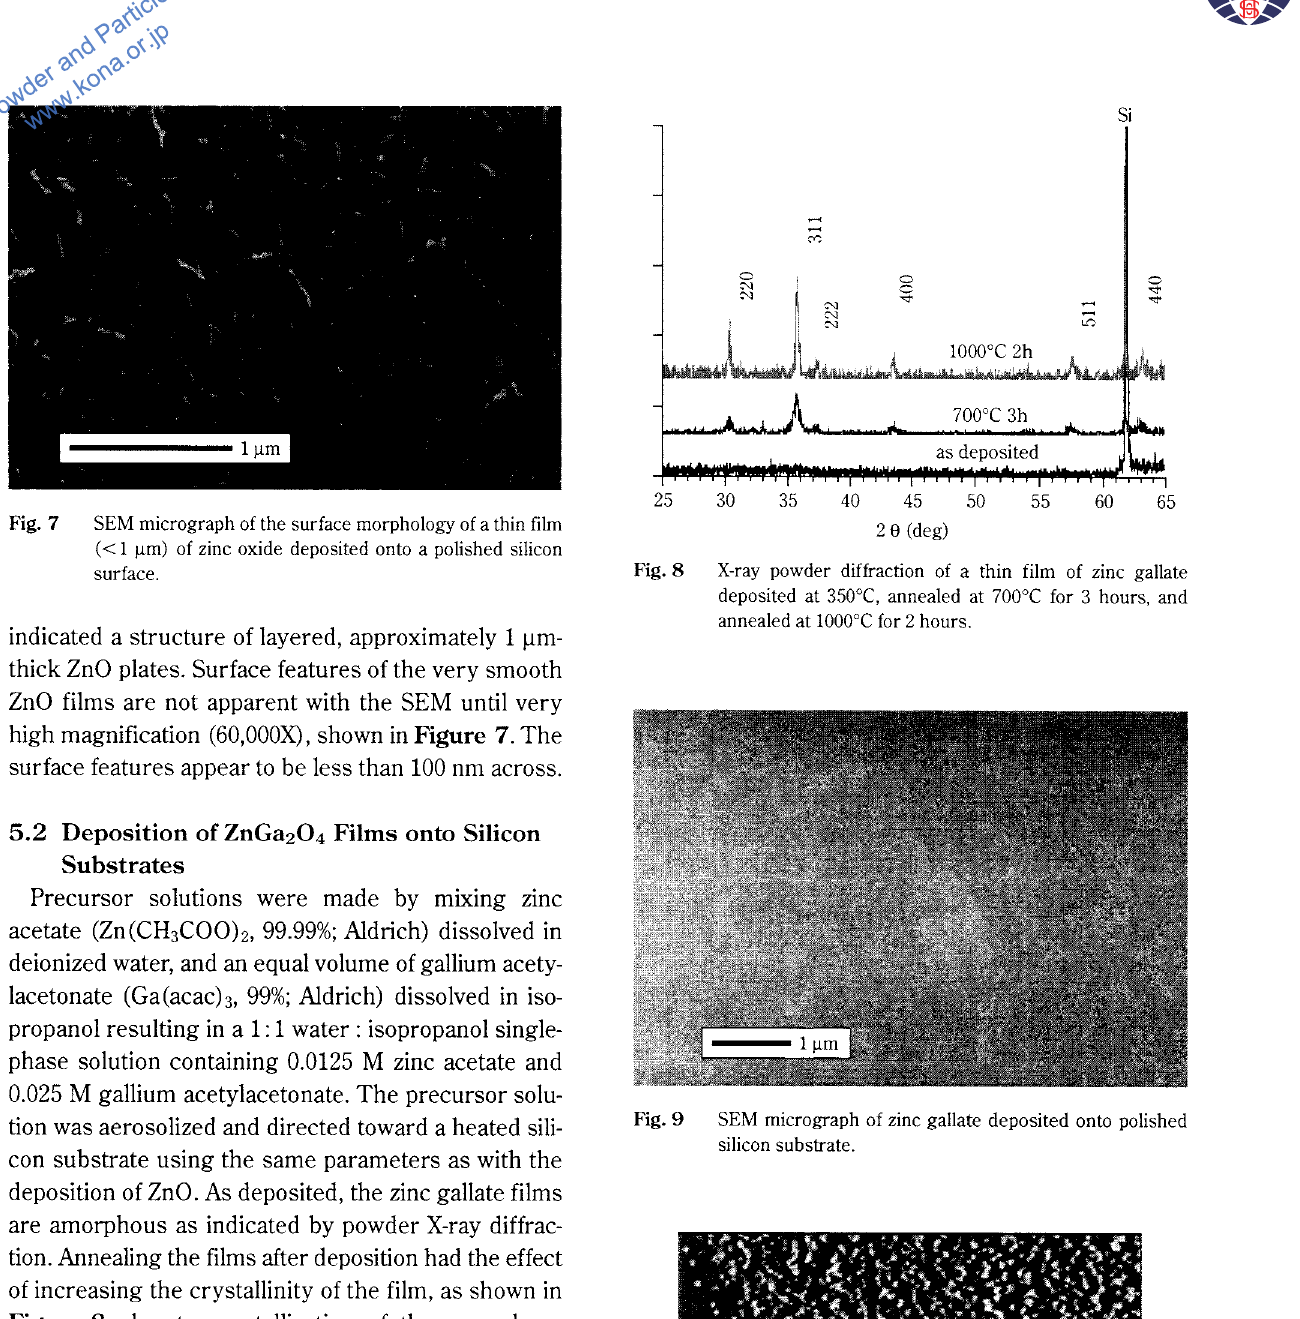
Fig. 9 SEM micrograph of zinc gallate deposited onto polished silicon substrate.